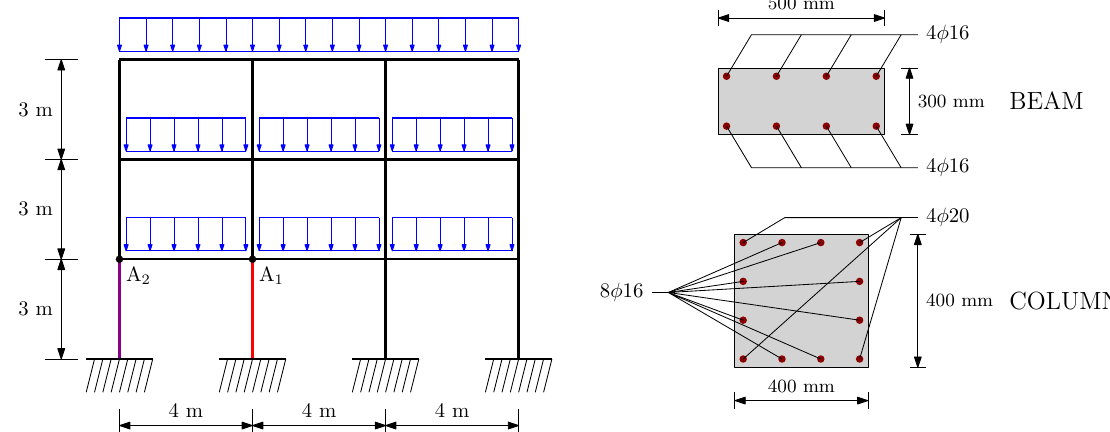
Figure 8. A sketch of the test frame onto which the simplified method is applied. The removed middle column is reported in red, the removed side column in violet. The corresponding control nodes are marked with letters A 1 and A 2 , respectively. The geometry and the reinforcement layouts of beams and columns are depicted on the right-hand